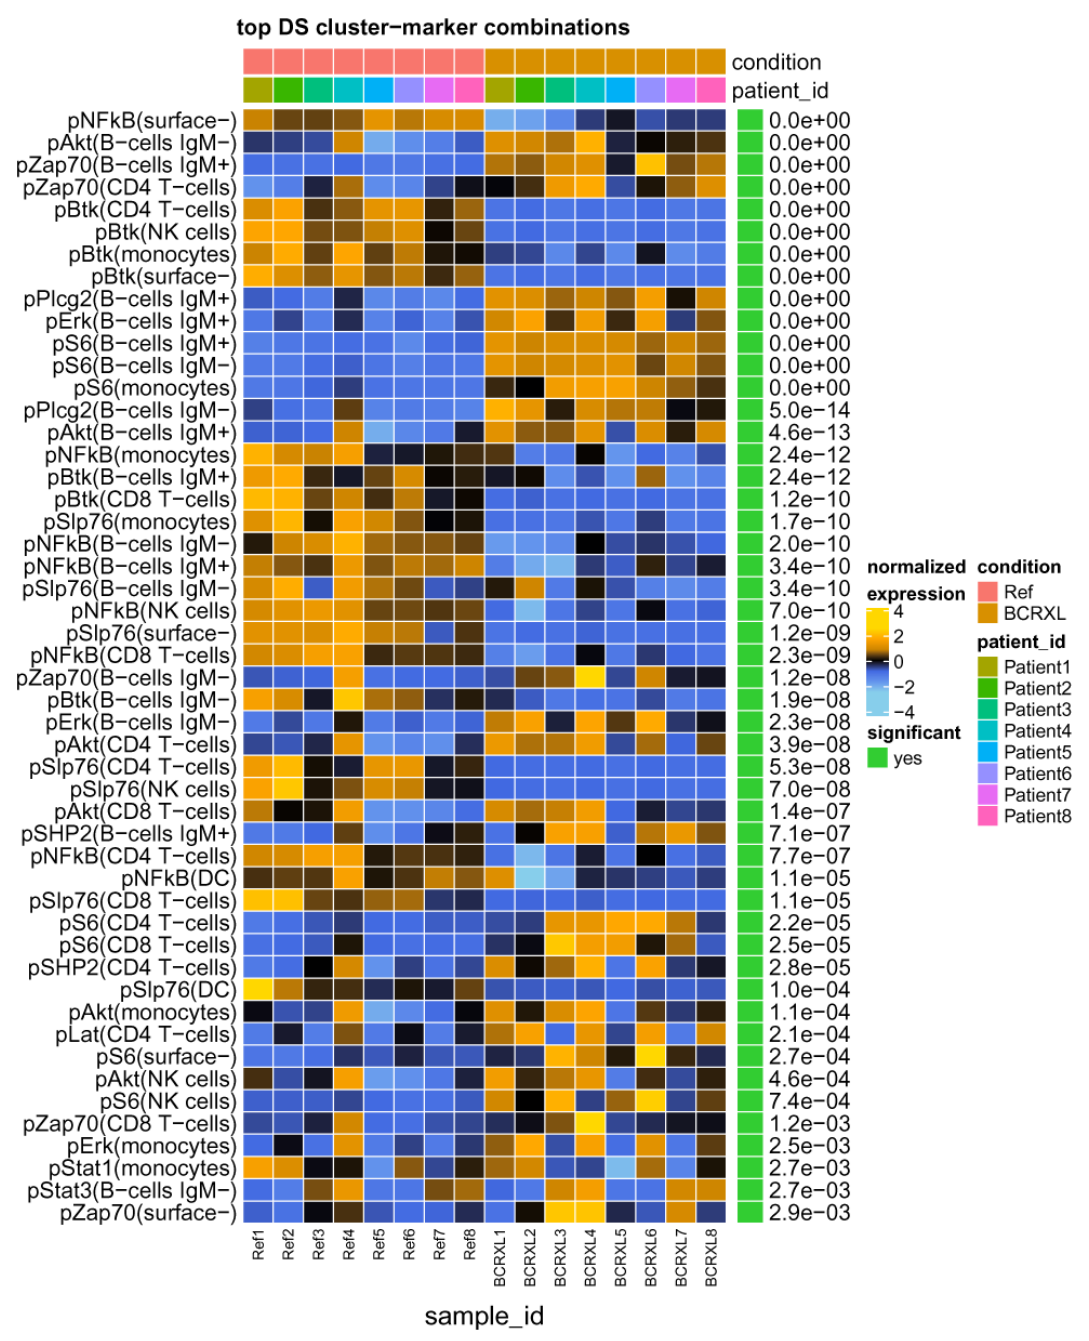
Figure 24. DS test results and normalized expression of signaling markers in PBMC populations in BCR/FcR- XL stimulated and unstimulated conditions. The heat represents median (arcsinh-transformed) marker expression that was subsequently normalized per cluster-marker combination (rows) to mean of zero and standard deviation of one. The color of the heat varies from blue representing relative under-expression to orange representing relative over- expression. Bars at the top of the heatmap indicate patient IDs and the condition the samples (columns) belong to: red for the unstimulated (Ref) and brown for the stimulated with BCR/FcR-XL (BCRXL) condition. Bar and numbers at the right indicate significant differential cluster-marker combinations (green) and adjusted p-values. Cluster-marker combinations are sorted according to adjusted p-value, so that the cluster-marker combinations at the top show the most significant differential signals between the two conditions. Shown are only the top 50 most highly significant cluster- marker